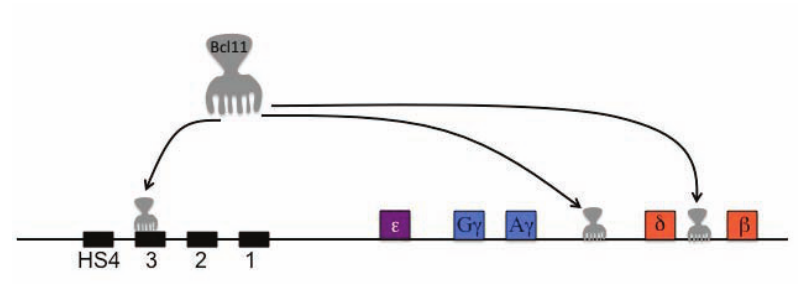
Figure 3. Regions of the β -globin cluster bound by Bcl11A in ChIP and ChIP seq stud- ies.